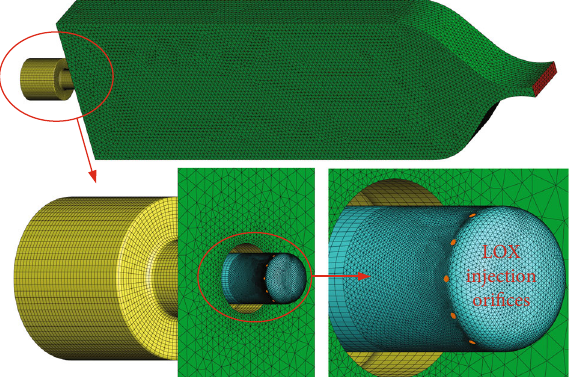
Figure 6: Computational mesh of LOX/GCH4 pintle rocket